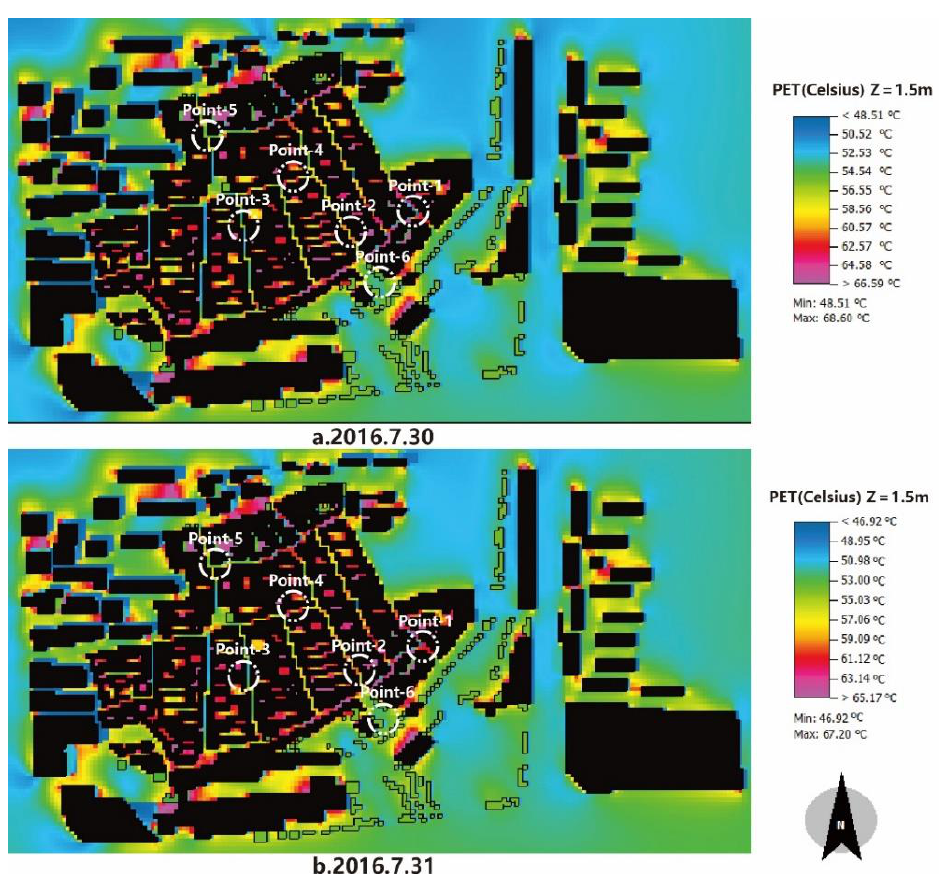
Figure 12. Spatial distribution of PET at 3:00 pm during the two measured days. ( a ): First day; ( b ): Second day.